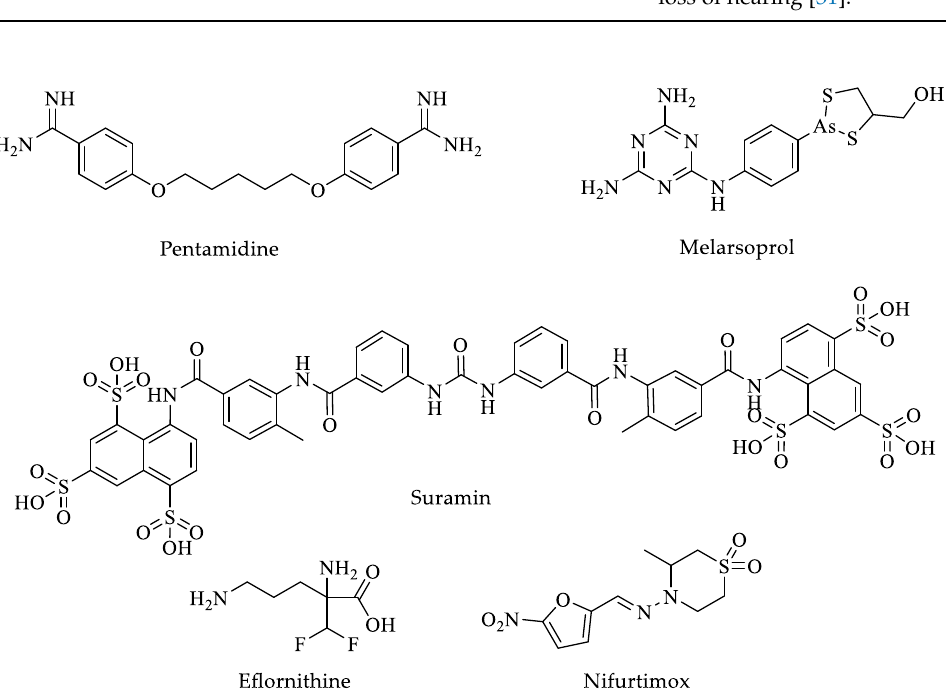
Figure 4. First and second-line drugs used against T. brucei .